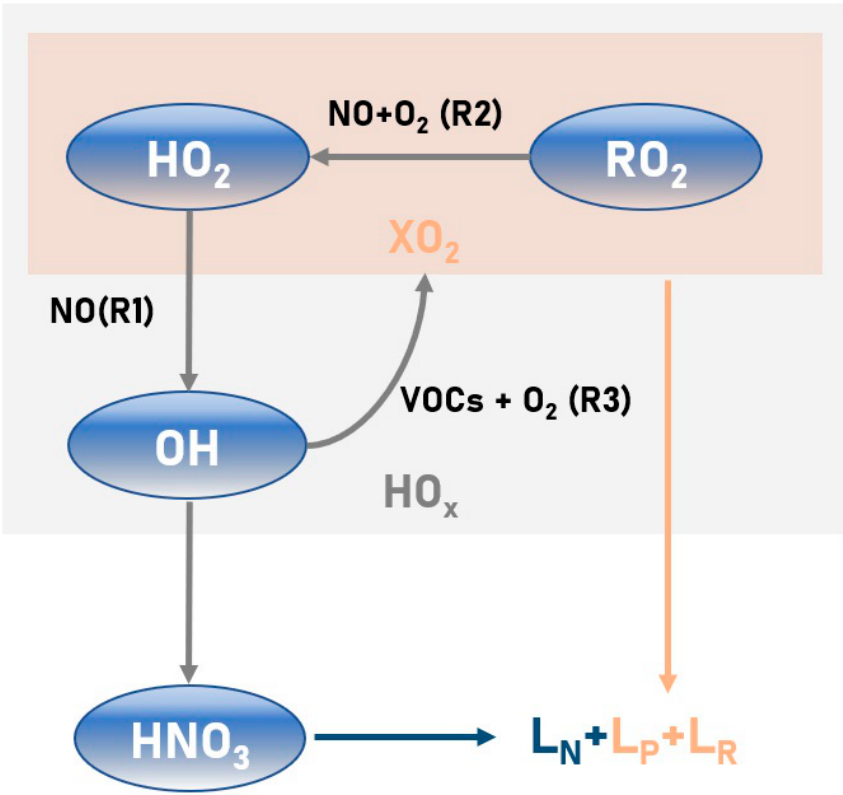
Figure 1. Theoretical framework of the HOx radical cycle. This framework considers the rates of radical losses due to particle uptakes (L P ), peroxide formation (L R ), and NO x reactions (L N ). Mainly, the reaction of NO with the peroxy radicals (XO 2 ≡ HO 2 + RO 2 ) (Equations (1) and (2)) and the reaction of OH with VOCs (Equation (3)) are included.